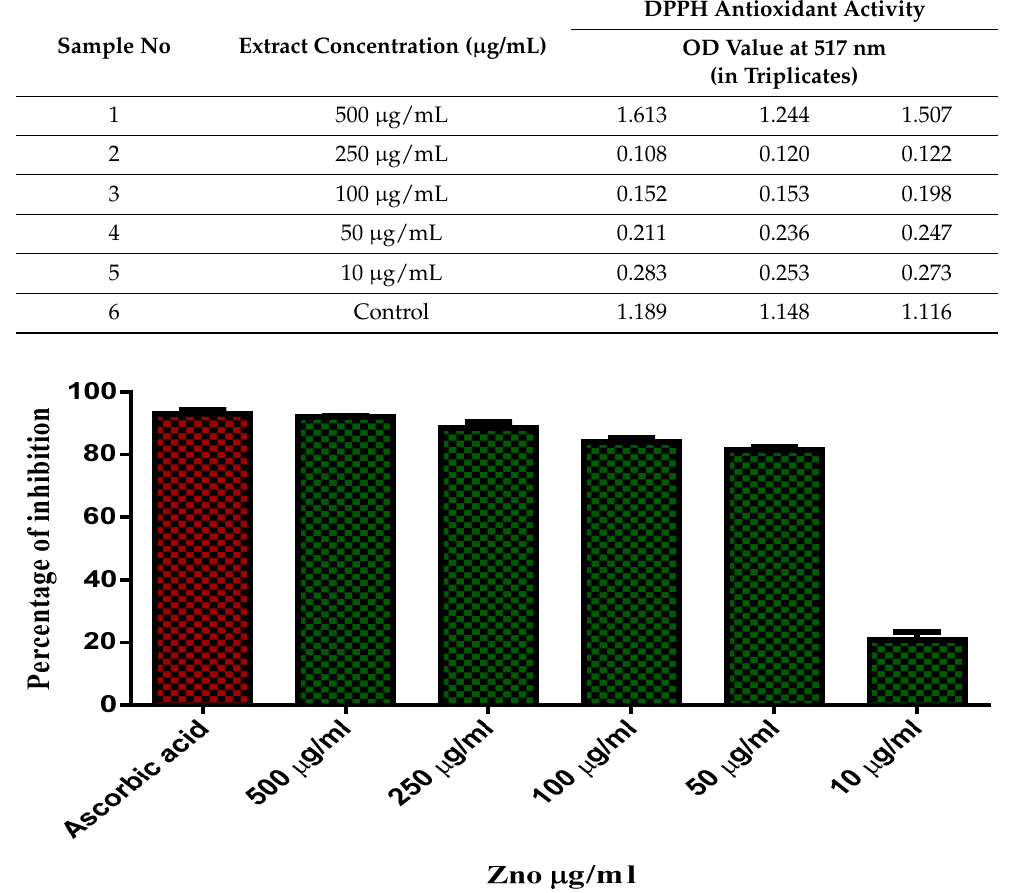
Figure 8. The Percentage inhibition concentration of Ascorbic acid. Table 7. The Percentage inhibition and IC 50 value of Ascorbic